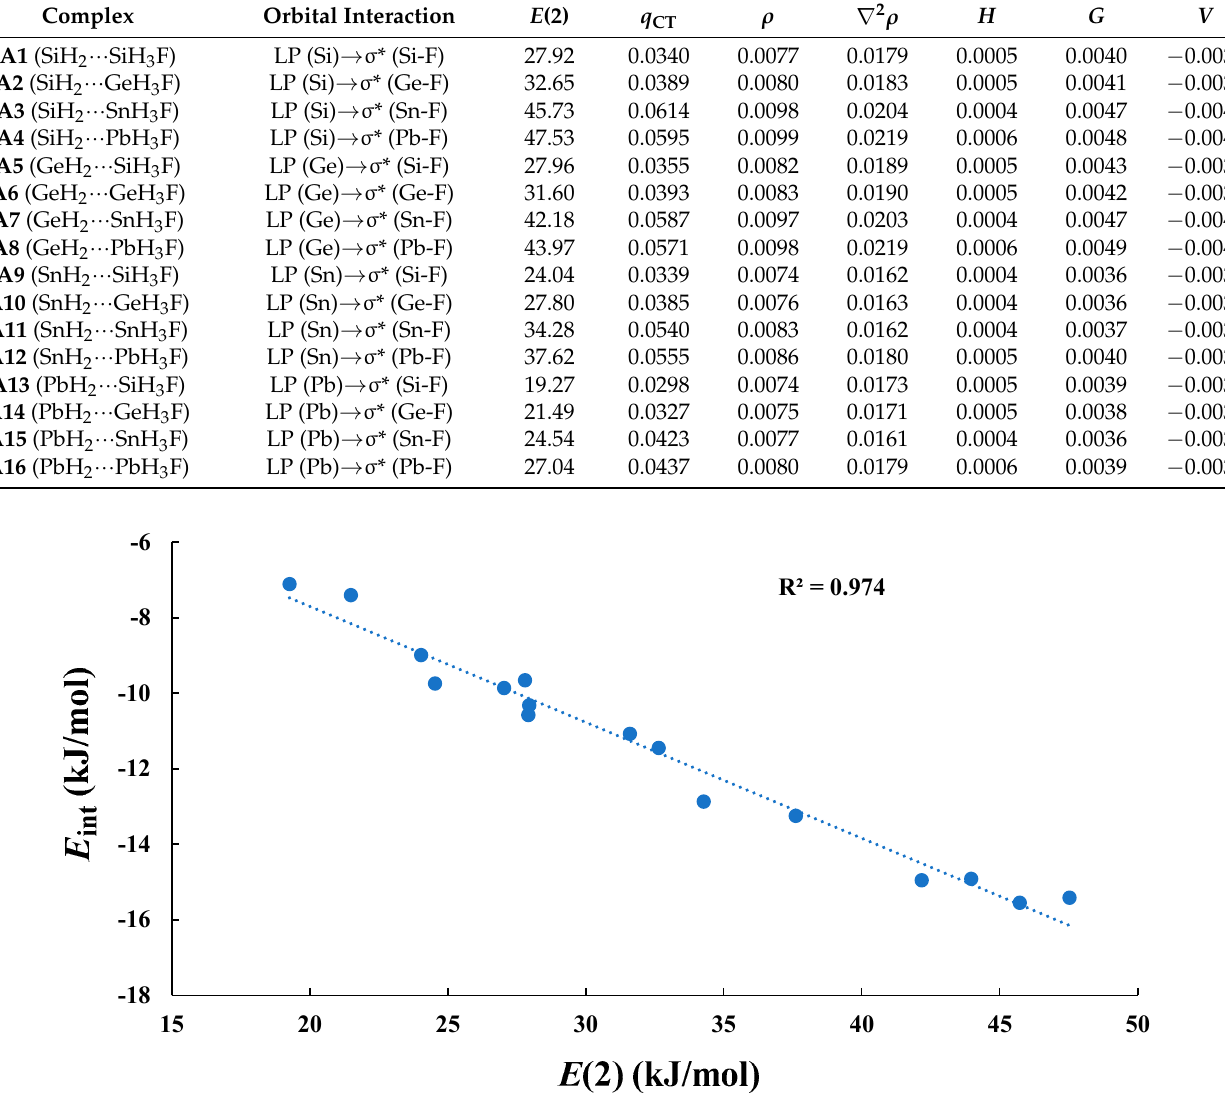
Table 2. Second-order perturbation stabilization energy ( E (2), in kJ/mol), charge transfer (qCT, in e), electron density ( ρ , in a.u.), Laplacian ( ∇ 2 ρ , in a.u.), energy density (H, in a.u.), local kinetic energy density (G, in a.u.) and potential energy density (V, in a.u.) at the BCP for type-A complexes. Complex Orbital Interaction E (2) q CT ρ ∇ 2 ρ V